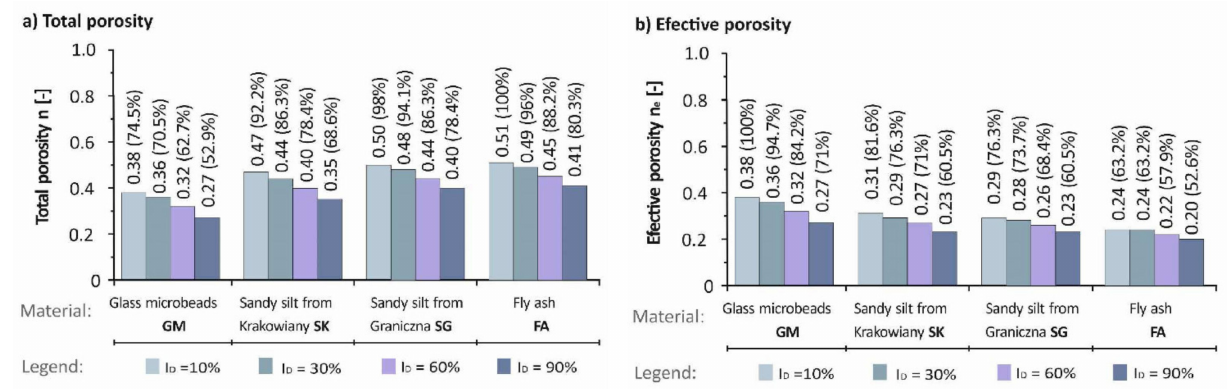
Figure 3. Porosity of the studied soil samples: ( a ) Total porosity, ( b ) Effective